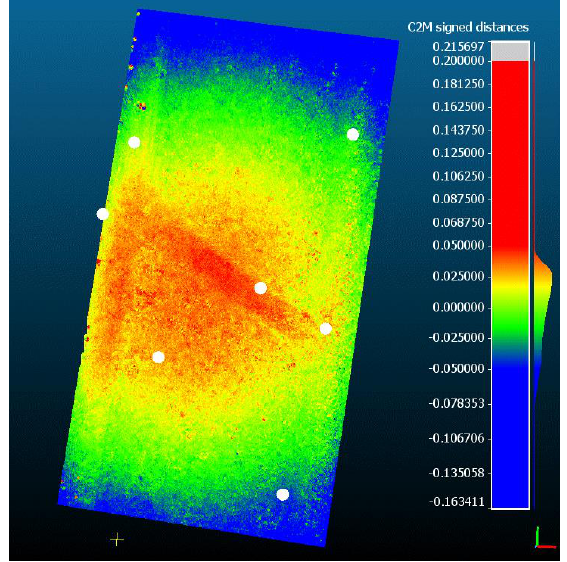
Figure 8. Dome-shaped deviations using GCPs without RTK